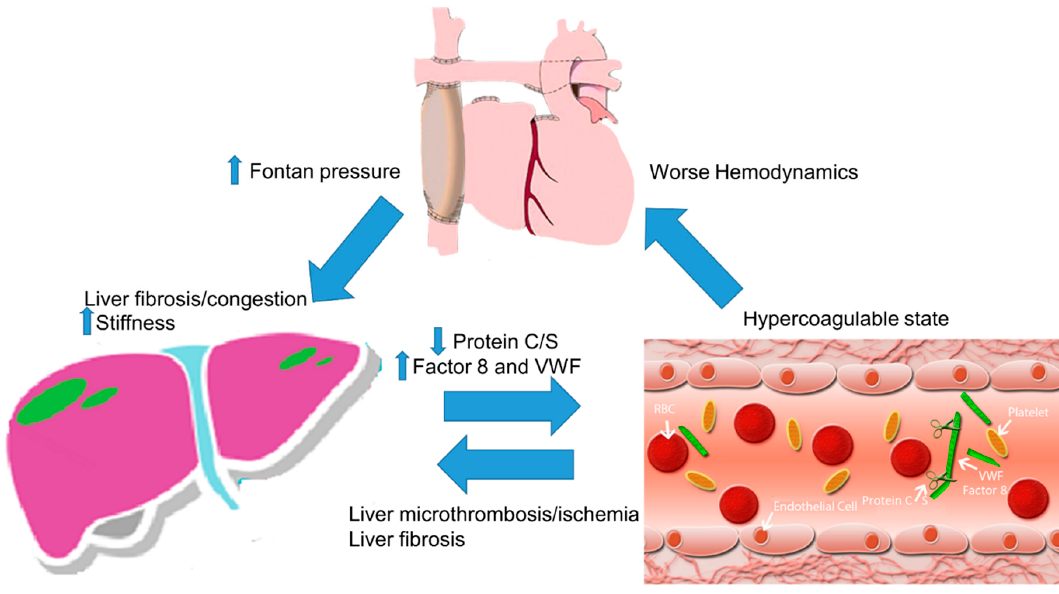
Figure 3. Increased Fontan pressure leads to liver congestion and fibrosis resulting in Fontan-associated liver disease. In turn, Fontan-associated liver disease results in decreased protein C and S and may worsen the hypercoagulable state. The hypercoagulable state may lead to liver microthrombi, activate liver fibrosis, and worsen hemodynamics, which results in a viscous cycle.